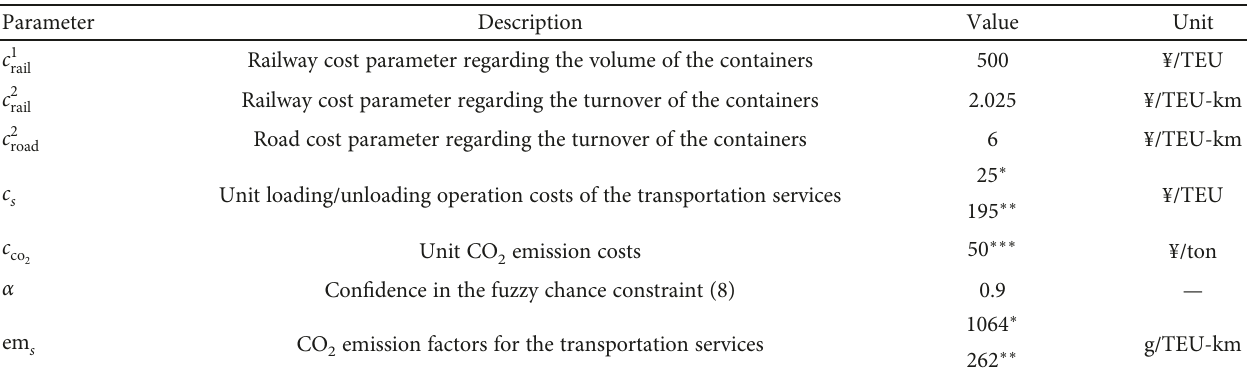
Table 3: Values of the parameters in the empirical case.